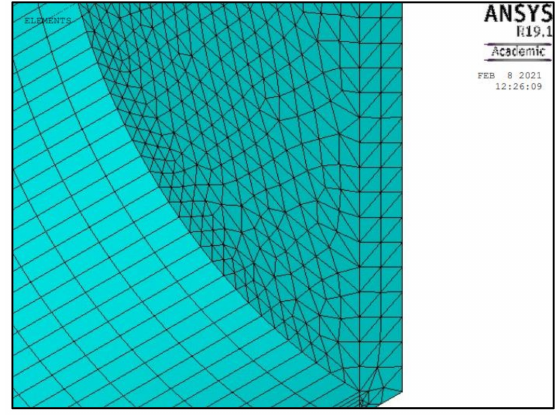
Figure 4. Tetrahedral SOLID186 elements used to mesh the